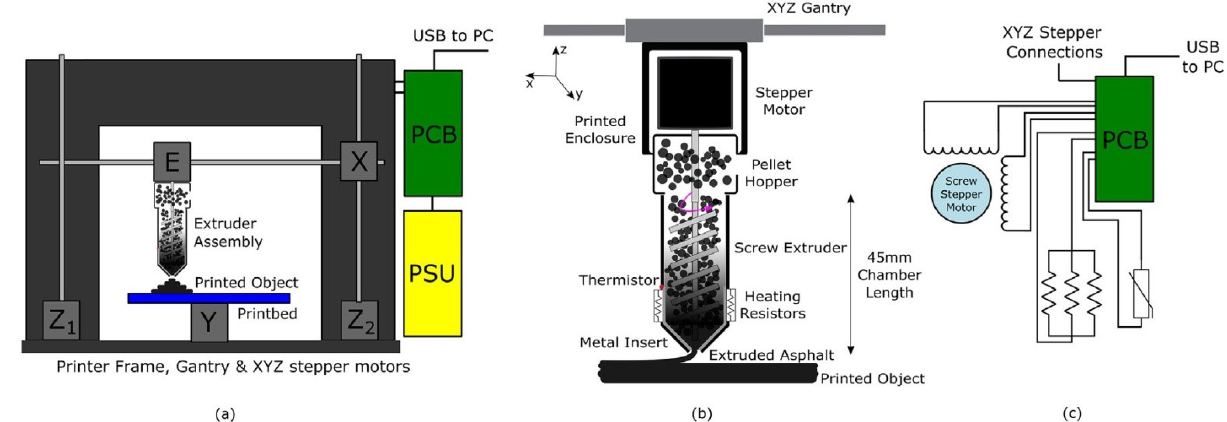
Figure 1: Schematic of 3DP machine